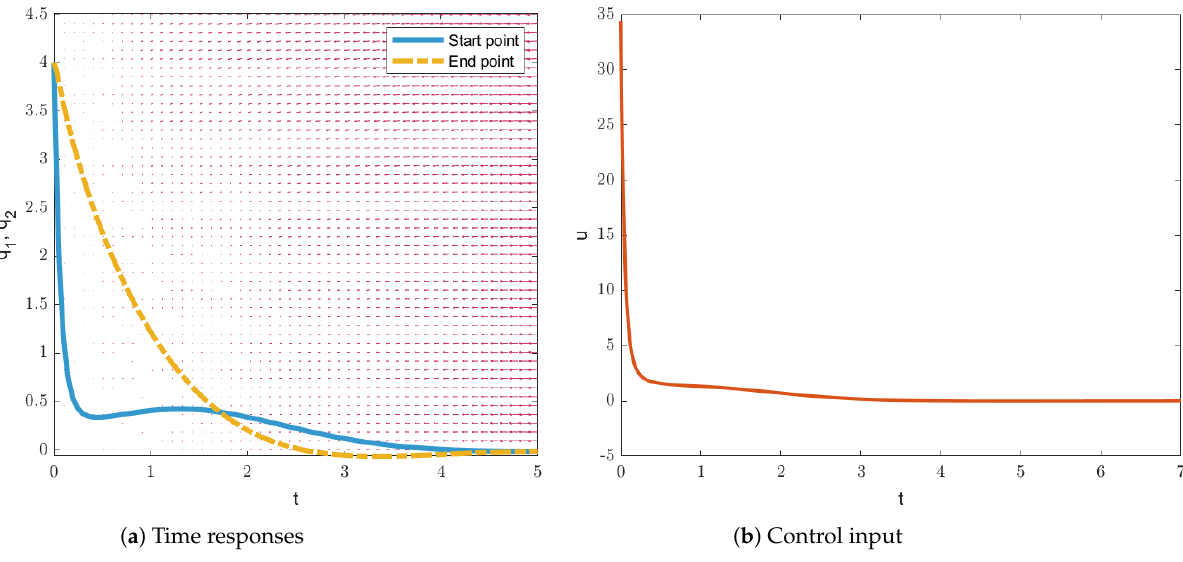
Figure 2. The time responses and the control input of the offered guaranteed cost controller for the initial condition q ( 0 ) = [ 4 4 ] T in Example